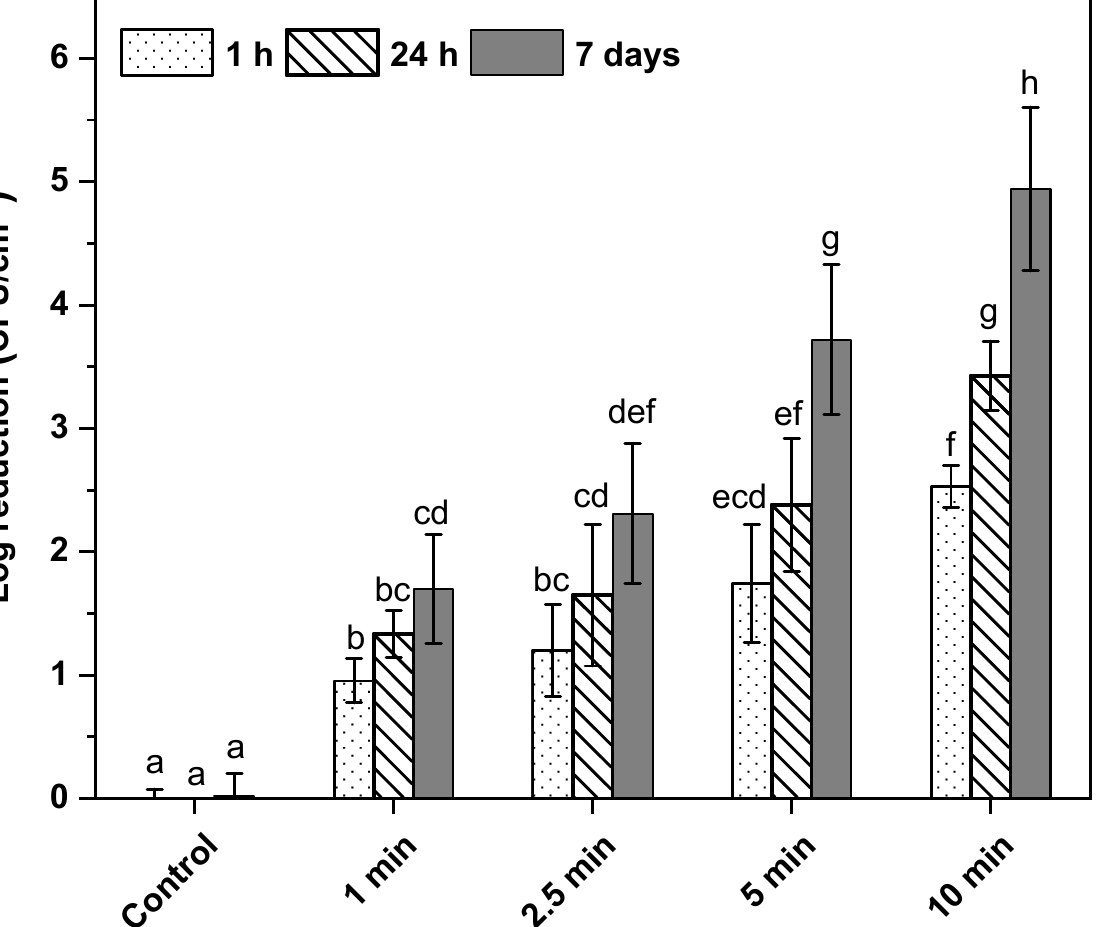
Figure 1. Mean cell counts of L. monocytogenes on ham surface after in-package ACP treatment and storage. White bar with dots represents post-treatment storage for 1 h at 4 ◦ C; white bar with hatch lines represents post-treatment storage for 24 h at 4 ◦ C; grey bar represents post-treatment storage for 7 days at 4 ◦ C. Data are shown as means ± standard deviations ( n = 3). Treatment means with different letters are significantly different.